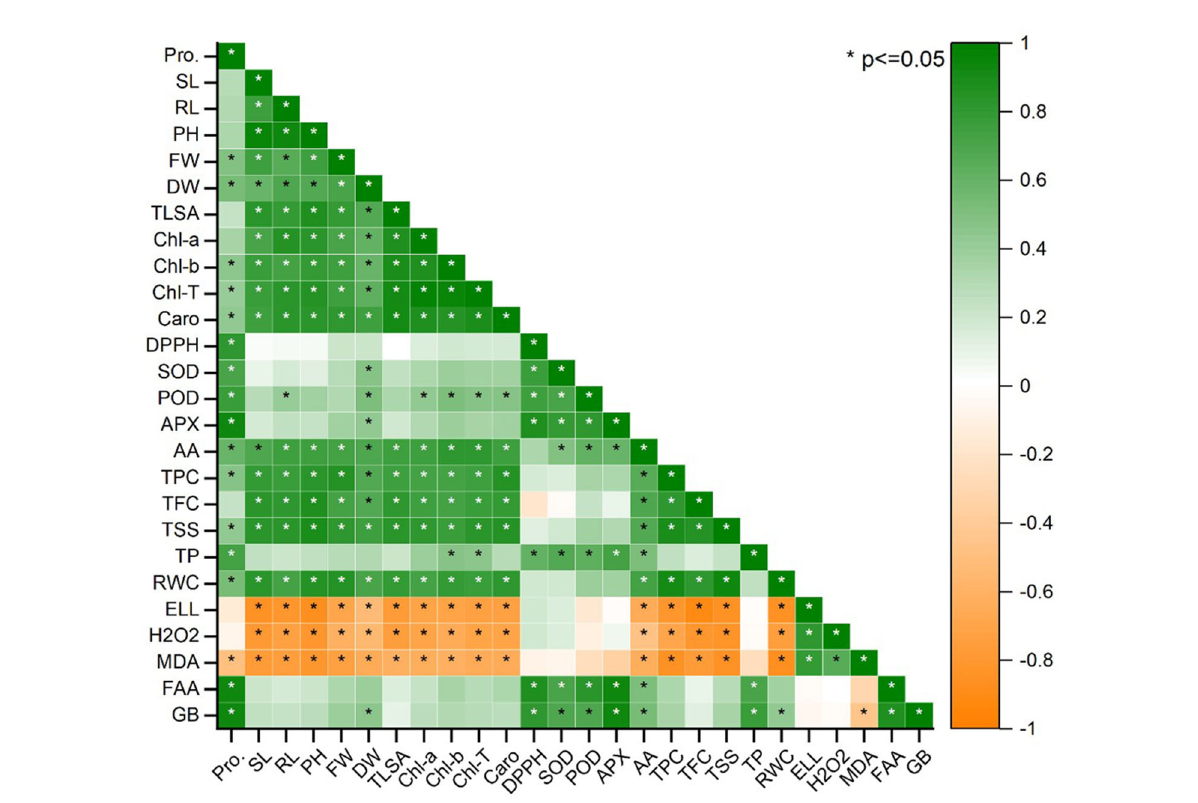
FIGURE8 Pearson correlation between antioxidants and biochemical traits with plant biomass parameters under salinity stress; Pro, (Proline), SL (Shoot length), RL (Root length), PH (Plant height), FW (Fresh weight), DW (Dry weight), LA (Leaf area), Chl a (Chlorophyll a), Chl b (Chlorophyll b), T. Chl (Total chlorophyll), Caro (Carotenoids), DPPH (Radical scavenging capacity), SOD (Superoxide dismutase), POD (Peroxidases), APX (Ascorbate peroxidase), AA (Ascorbic acid), TPC (Total phenolic content), TFC (Total flavonoid content), TSS (Total soluble sugars), TP (Total Protein), RWC (Relative water content), EL (Electrolyte leakage), H 2 O 2 (Hydrogen peroxide), MDA (Malondialdehyde), FAA (Free amino acids), GB (Glycine betaine). The treatments exhibit ( * ) within rows that represent a significance ( p ≤ 0.05)